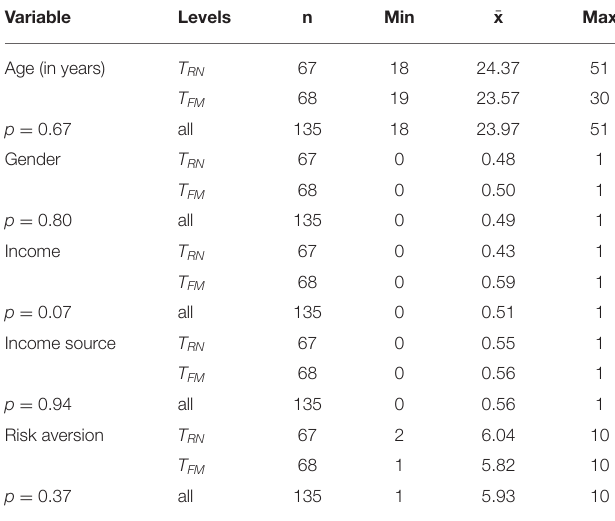
TABLE 1 | Summary statistics by